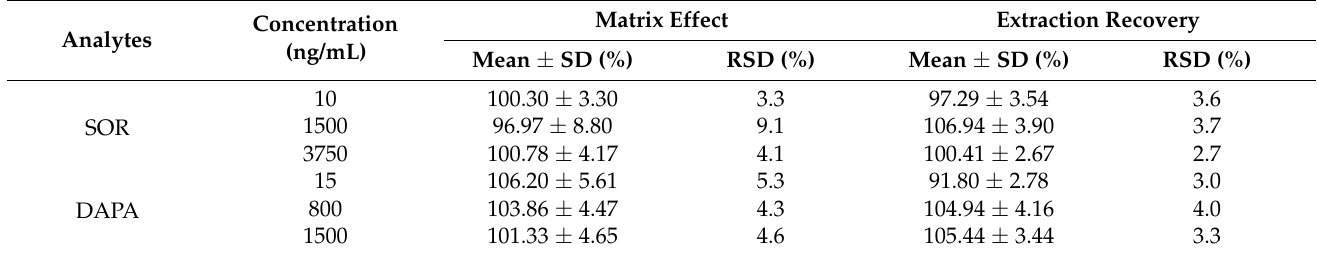
Table 2. Matrix effects and extraction recovery of SOR and DAPA in rat plasma ( n = 6).